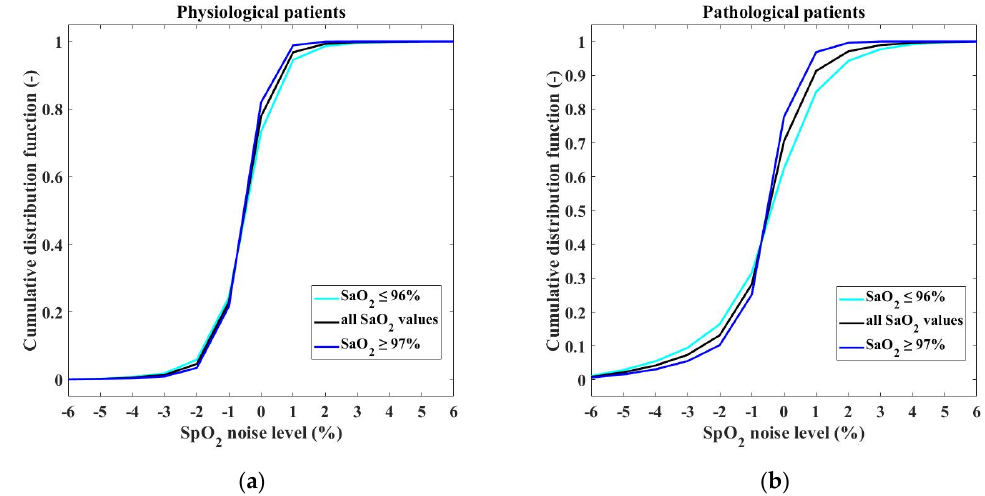
Figure 9. Cumulative distribution functions of the SpO 2 measurement noise for ( a ) physiological and ( b ) pathological patients.